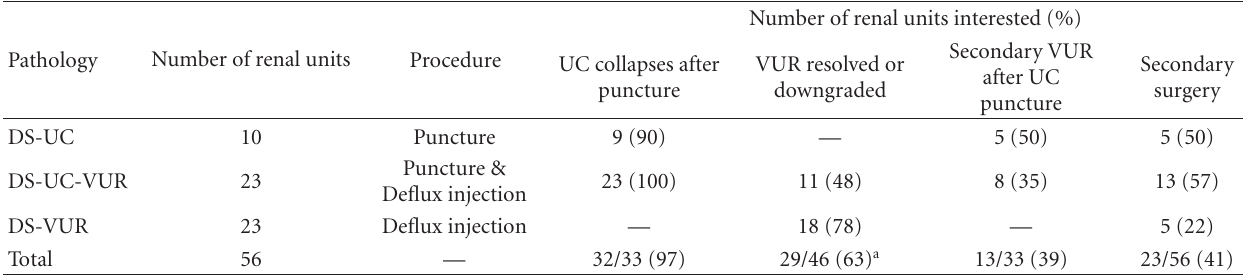
Table 1: Details of the all-endo treatment approach for duplicated renal unit.